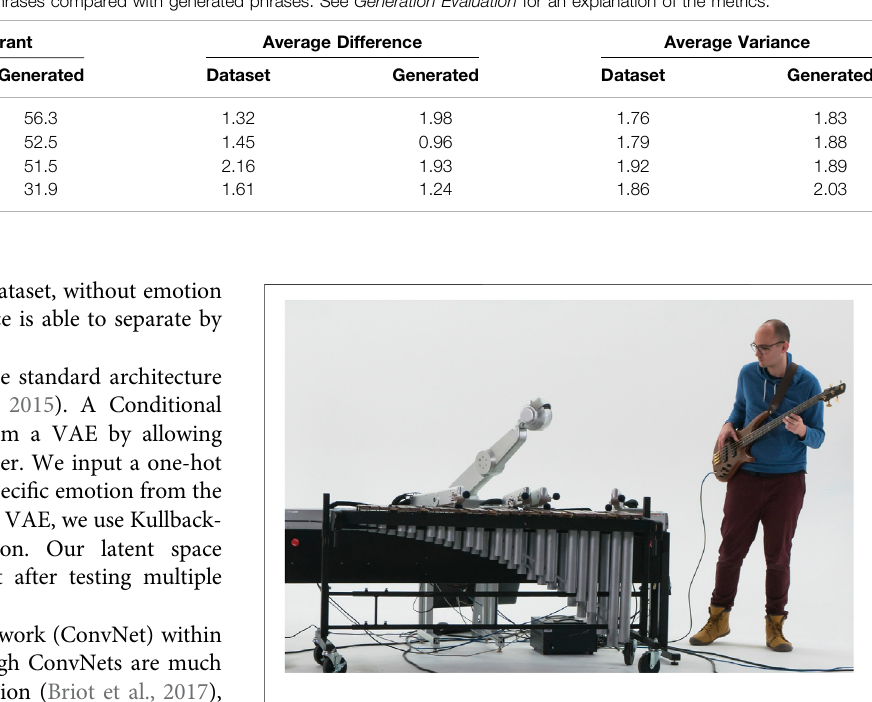
FIGURE 5 | Shimon the robotic marimba